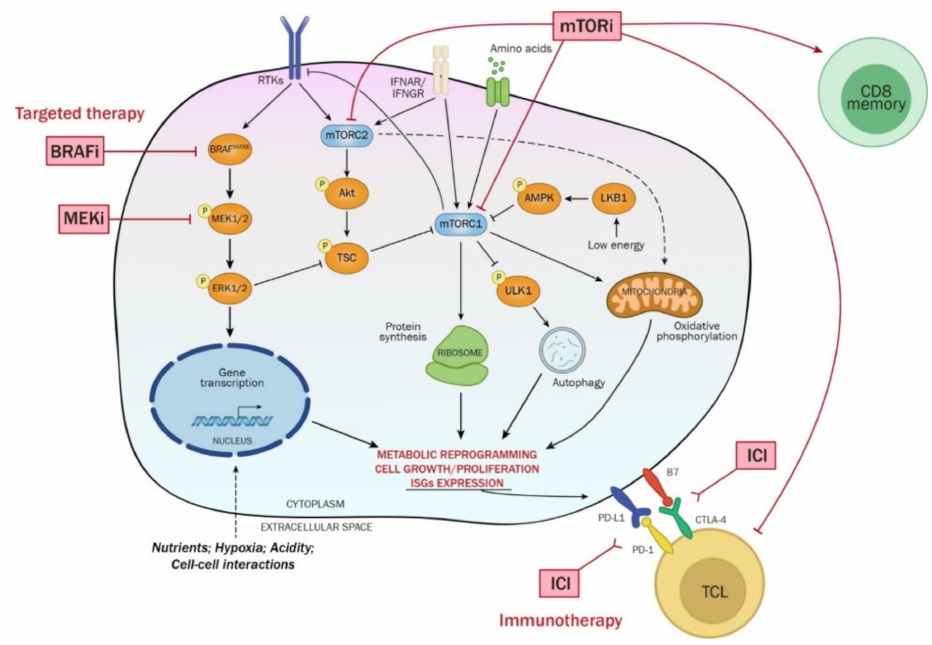
Figure 3. Summary of the cellular processes regulated by mTOR pathway and its connections with the BRAF/MEK/ERK signaling cascade. mTOR complexes are activated by various extra- and intracellular stimuli related to the energetic status of the cell and nutrient availability in the extracellular space. mTORC1 functions can be regulated by the BRAF pathway via an ERK-dependent mechanism and mTORC1 itself exerts a negative feedback mechanism on RTKs signaling, inhibiting mTORC2 and BRAF/MEK/ERK pathways. mTOR complexes support therapeutic resistance of melanoma cells by boosting ATP production of the mitochondria, by enhancing protein synthesis. mTORC1 and mTORC2 also promote the expression of Interferon-stimulated genes (ISGs), potentially modulating anti-tumor immune responses. Note that mTORC1 inhibition can play a role in the switch toward therapeutic resistance by removing a brake on autophagy. Additionally, systemic mTOR inhibition can play both immunosuppressive and immunostimulatory roles by impairing CD8+ cytotoxic T cells (TCL) and by favoring the expansion of CD8+ memory T cells (CD8 memory). i: inhibitors; ICI: immune checkpoint inhibitors; AMPK: AMP-activated protein Kinase; TSC: tuberous sclerosis; IFNAR/IFNGR: interferon